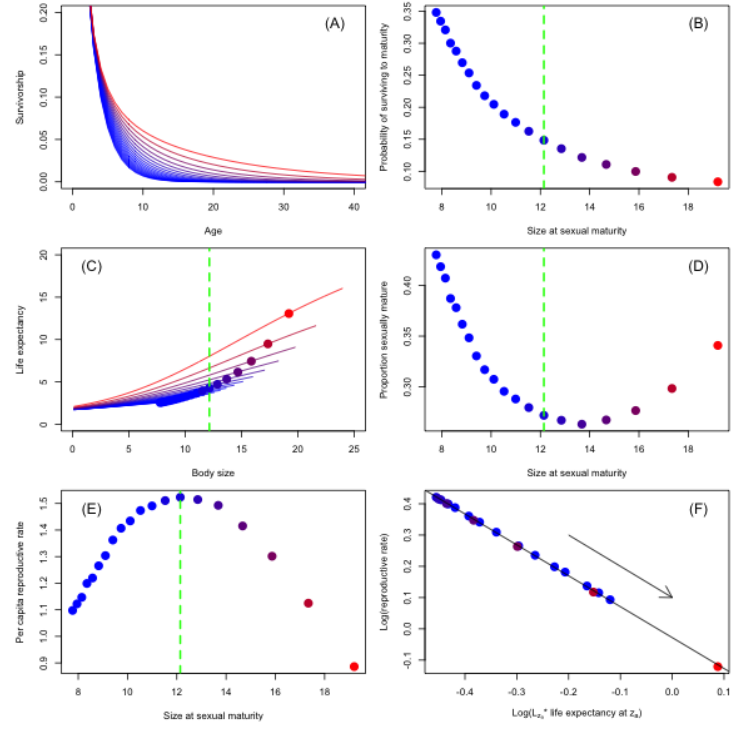
Figure 3. Figure 3. Model dynamics for the density-dependent reproduction scenario. (A) survivorship functions for each life history, (B) survivorship to sexual maturity as a function of size at sexual maturity, (C) life expectancy as a function of body size, (D) proportion of population that is sexually mature as a function of size at sexual maturity, and (E) per-time step per-capita reproductive rate as a function of size at sexual maturity, and (F) trade-off between the log of the density-independent rates with the log of the per-capita per-time step reproductive rate (the arrow represents the direction of evolution). The x-axis label is the combination of the density-independent life history traits. The dotted green vertical lines in (B-E) represent the life history of minimum fitness (i.e., lowest carrying capacity). Fitness increases either side of the green line. Each point represents one of our 20 life histories. The redder the colour of a point, the fitter the life history strategy. Note that Fig 3(D) uses identical data to Fig 2(E) but in Fig 3(D) we draw the vertical line of minimum